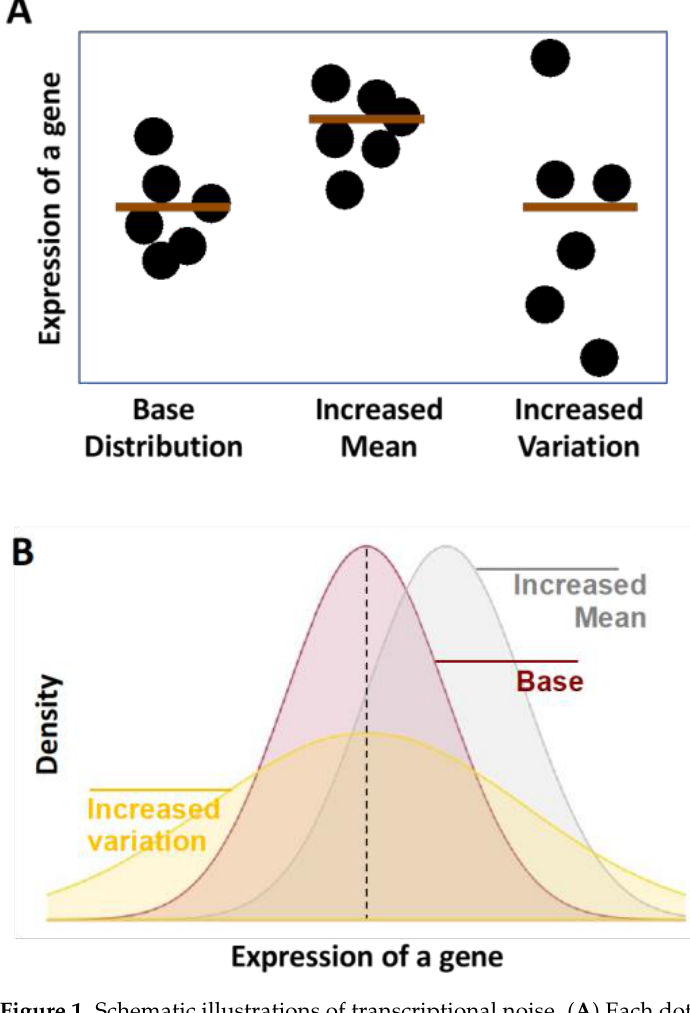
Figure 1. Schematic illustrations of transcriptional noise. ( A ) Each dot presents the expression level of a gene in one cell. ( B ) Distributions of expression levels of a gene across populations of cells are shown.